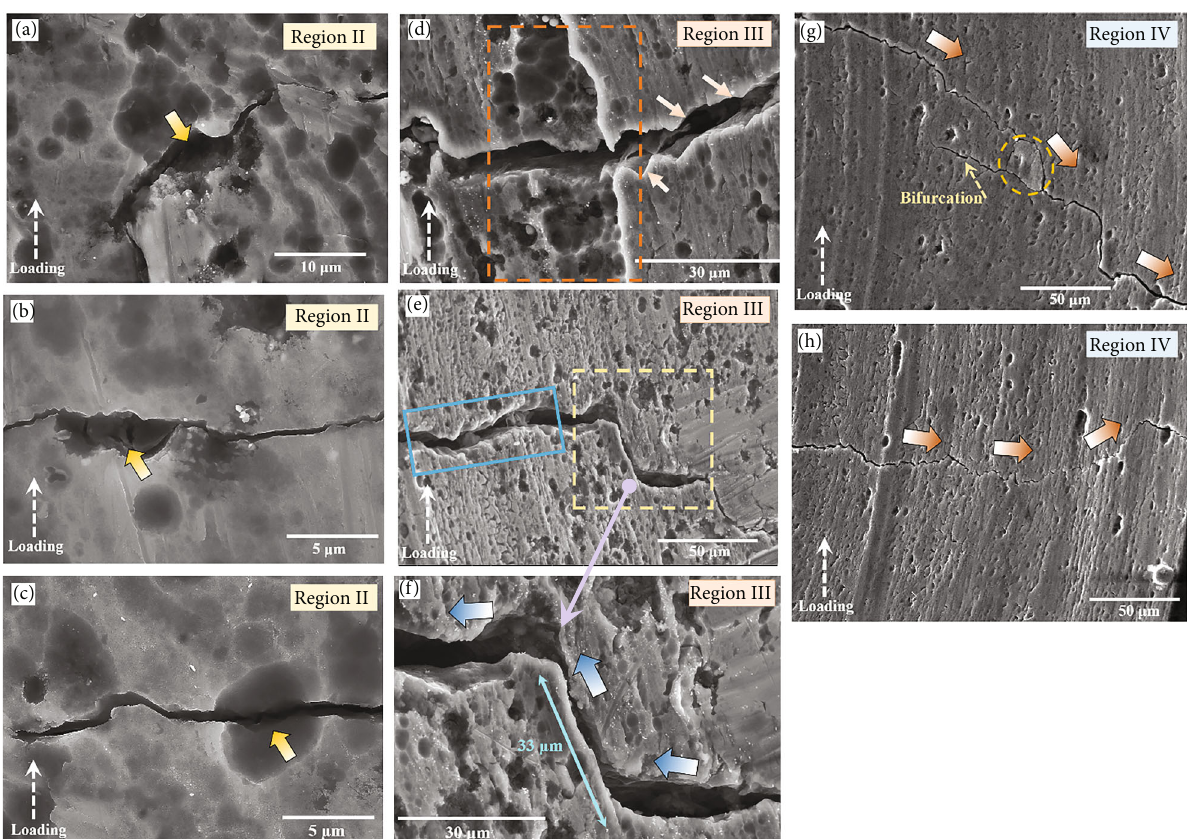
Figure 7: SEM micrographs of crack characteristics along paths of cracks A and B: (a – c) magni fi ed view of region II in Figure 6(a); (d – f) magni fi ed view of region III in Figure 6(a); (g, h) magni fi ed view of region IV in Figure 6(a).